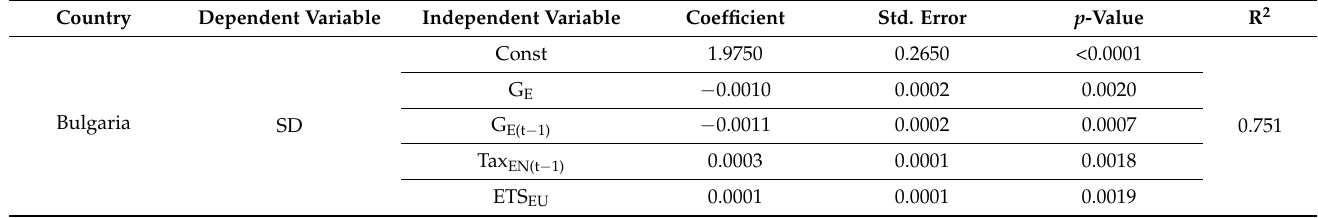
Table 3. Results of OLS regressions in the analyzed countries from 2008 to 2022 ( p <